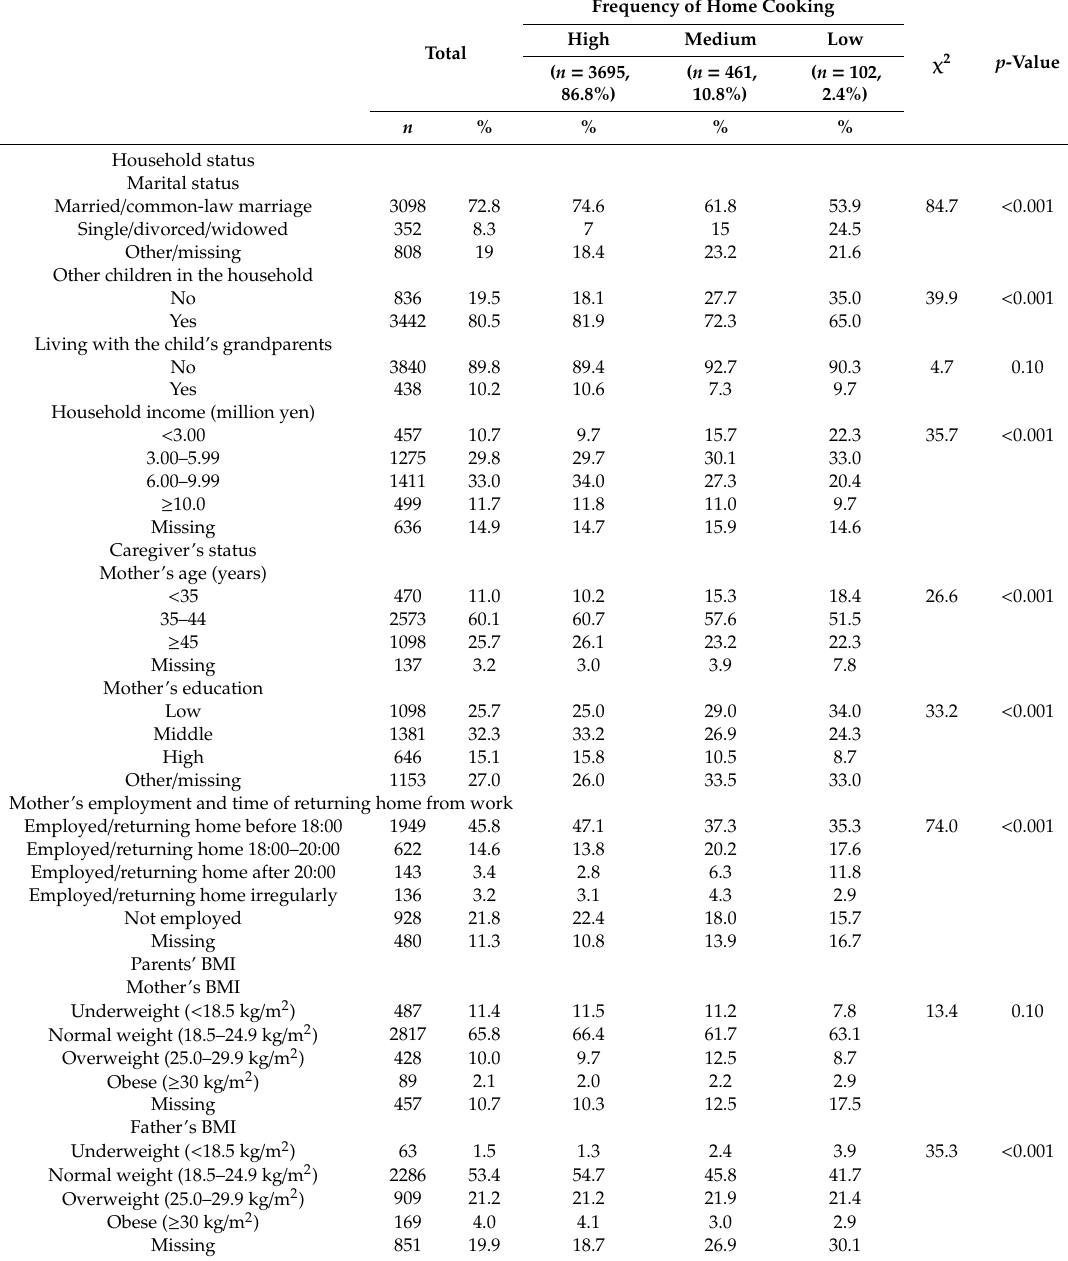
Table 2. Characteristics of participating households and caregivers ( n =